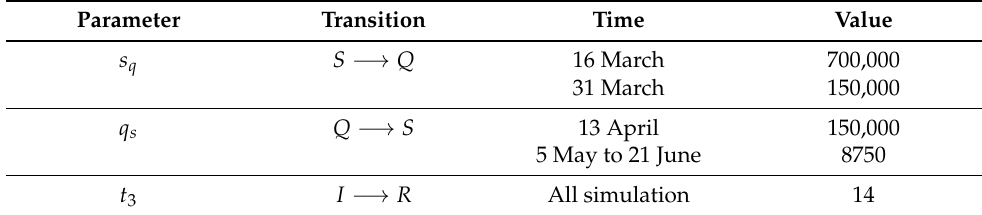
Table 1. Summary of the known model parameters.